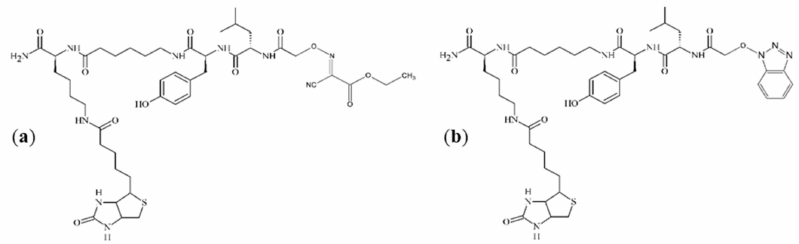
Figure 4. The proposed chemical structures of impurities, visible on the spectrum as ions at m / z equal to: ( a ) 943.5; ( b )